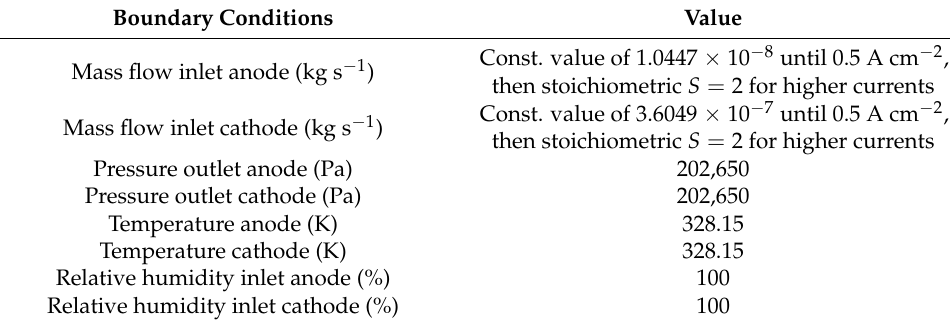
Table 5. Boundary